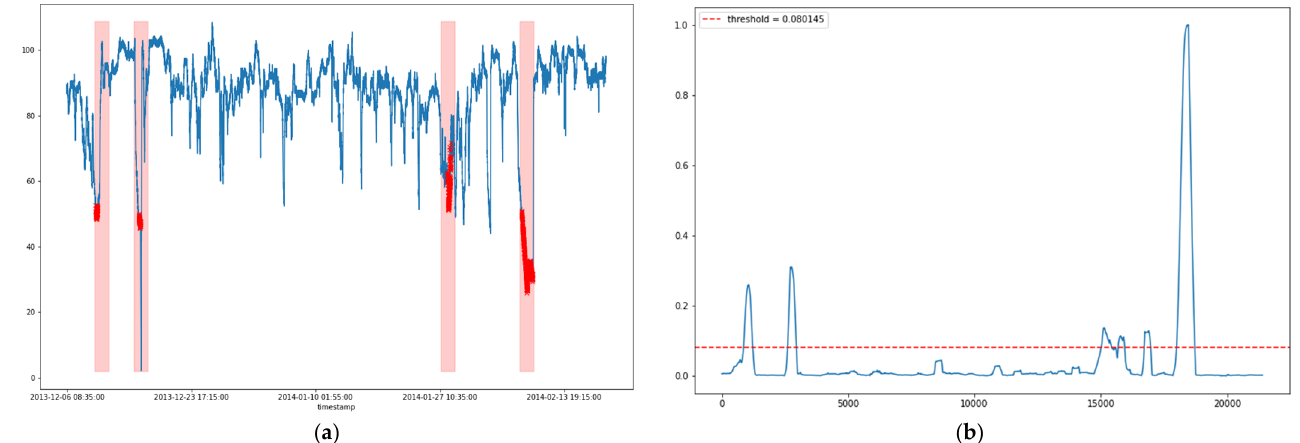
Figure 6. Anomaly detection by our SSL method for NAB Machine Temperature dataset. ( a ) Anomaly points with original NAB Machine Temperature dataset; ( b ) anomaly score with threshold.